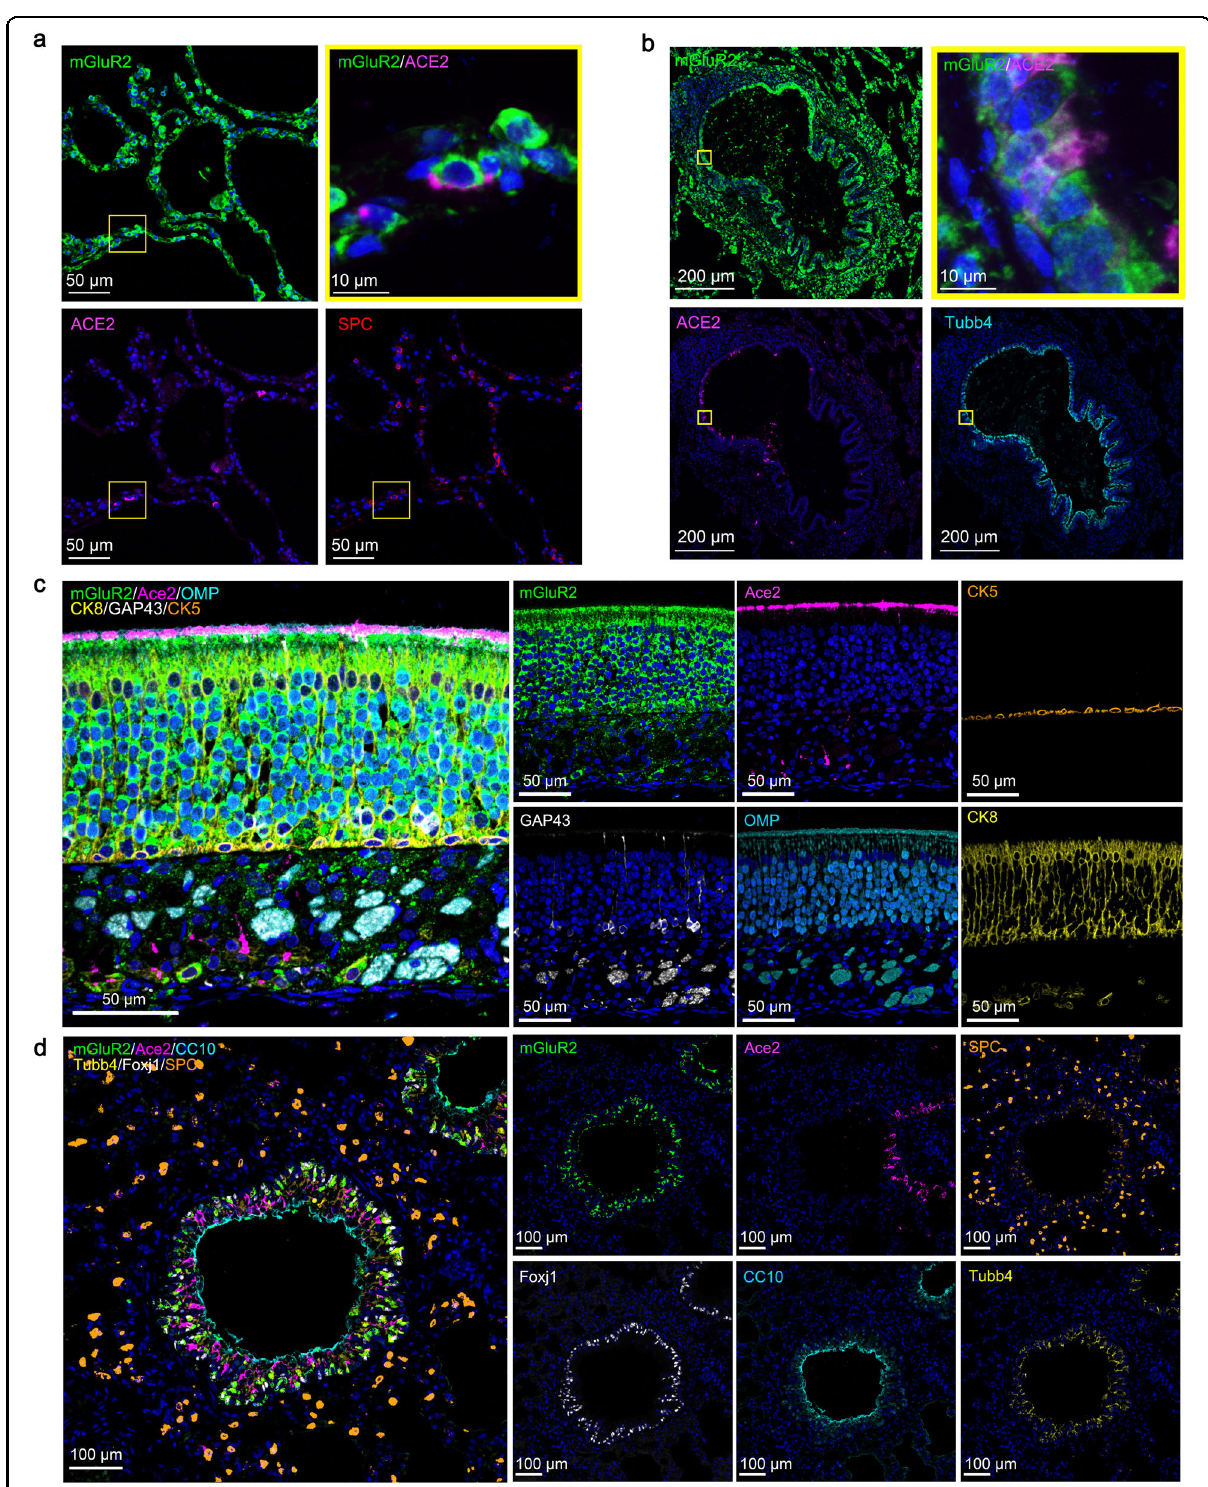
Fig. 4 mGluR2 is expressed in the respiratory system. a , b Multiplex immuno fl uorescence staining for the detection of mGluR2-positive cells in a normal human lung section. mGluR2 (green), ACE2 (magenta), Tubb4 (cyan), and SPC (red). The yellow areas are shown adjacently at a higher magni fi cation in the alveoli ( a ) or bronchia ( b ). c Multiplex immuno fl uorescence staining for the detection of mGluR2-positive cells in olfactory epithelium sections of young mouse. mGluR2 (green), Ace2 (magenta), GAP43 (white), CK5 (gold), CK8 (yellow), and OMP (cyan). d Multiplex immuno fl uorescence staining for the detection of mGluR2-positive cells in lung sections of young mouse. mGluR2 (green), Ace2 (magenta), Foxj1 (white), SPC (gold), Tubb4 (yellow), and CC10